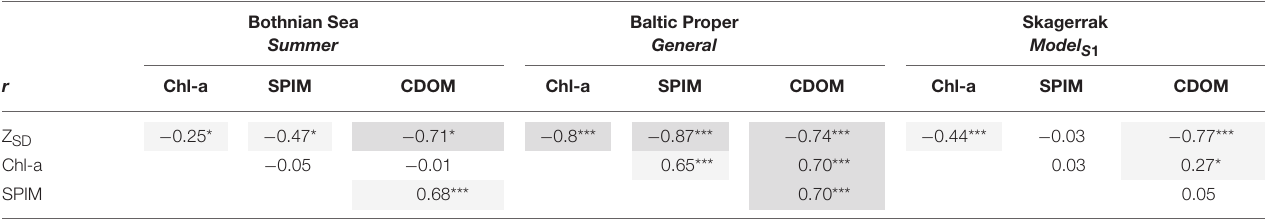
TABLE 5 | Table showing the Pearson correlation coefficient, r, for each data set, where *, *** denotes significant correlations at 0.01 and 0.0001 levels and no star indicates n.s. Bothnian Sea